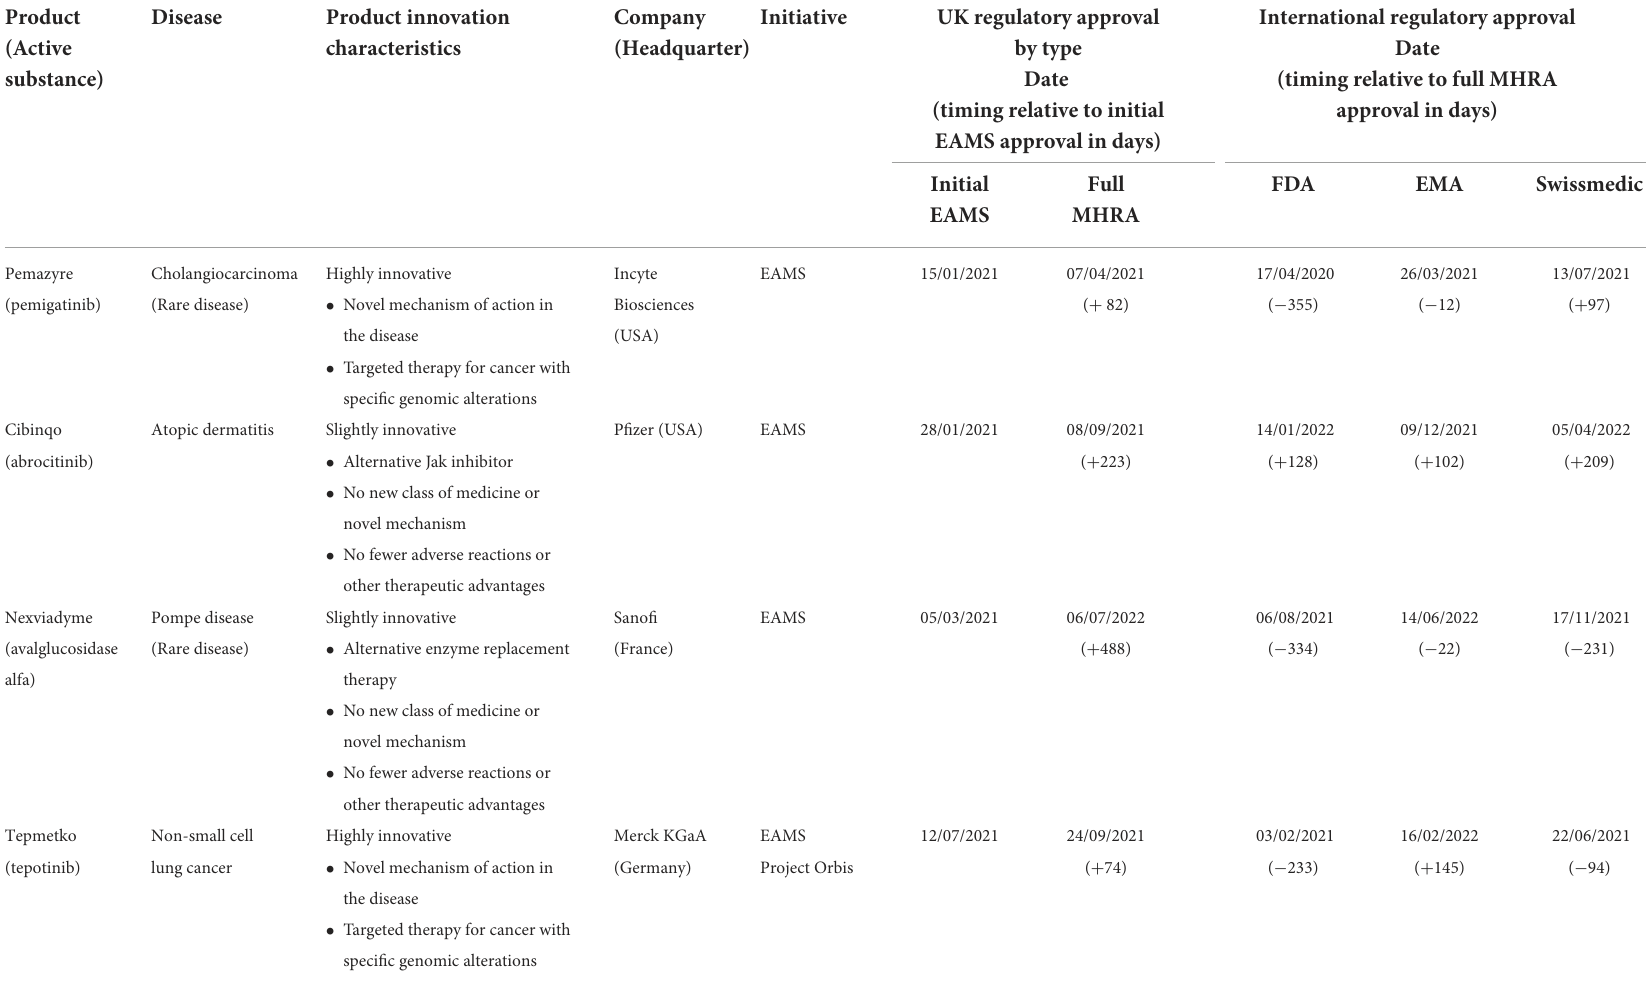
TABLE 2 MHRA products authorized via innovation initiatives in